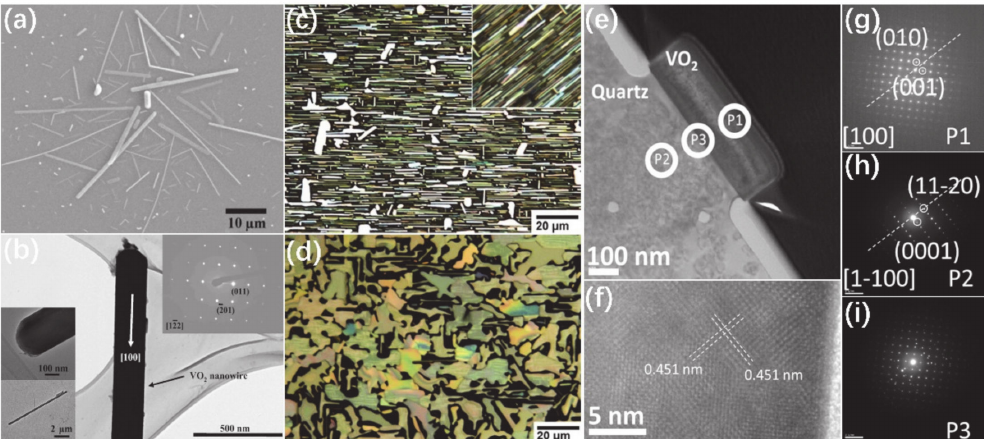
Figure 10. ( a ) SEM image of VO 2 NWs. ( b ) TEM image of an individual VO 2 NW. The insets are SEAD pattern and low-magnification TEM images of the growth front and the whole VO 2 NW. Reproduced from [81], with permission from Elsevier, 2008. ( c , d ) The morphologies of the grown NWs and microplates. ( e ) TEM image of the cross-section of the interface between single NW and quartz substrate. ( f ) HRTEM image of VO 2 NW. ( g – i ) The corresponding SAED patterns of the areas labelled with P1 (VO 2 ), P2 (quartz), P3 (interface). Reproduced from [82], with permission from Springer Nature,